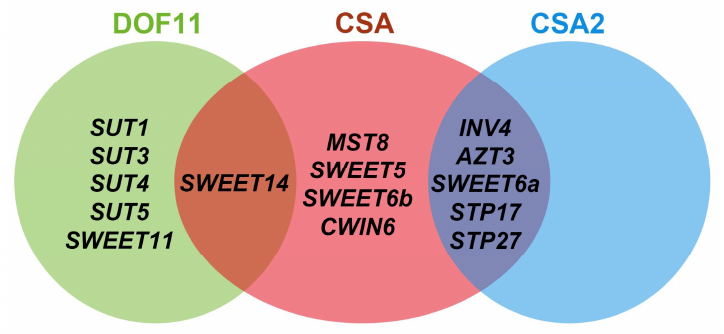
Figure 3. Sugar transport genes regulated by DOF11, CSA, and CSA2 in rice.